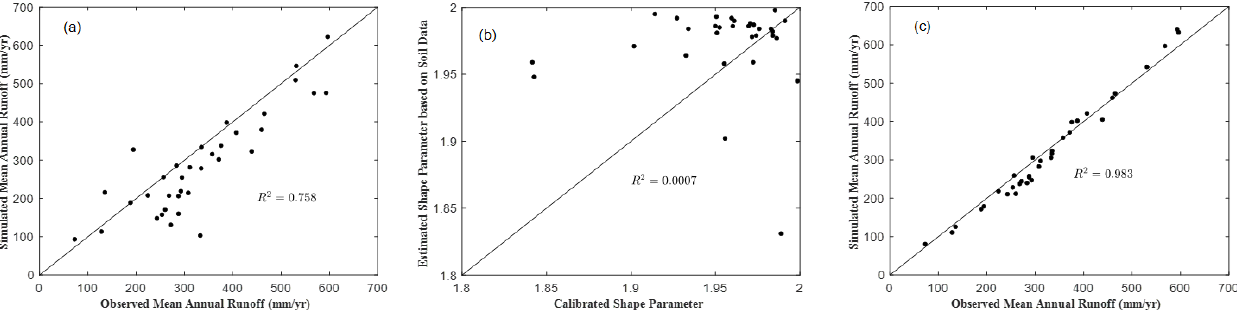
Figure 6. (a) Observed versus simulated mean annual runoff using shape parameter based on soil data; (b) Soil data-based versus calibrated shape parameter; and (c) observed versus simulated mean annual runoff using shape parameter based on calibration.